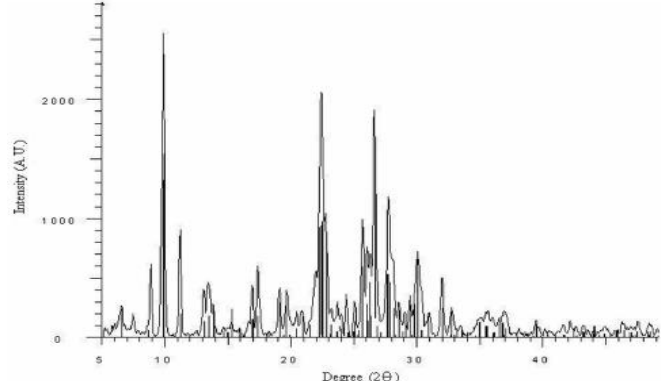
Fig. 1. XRD analysis of Miyaneh clinoptilolite Figure 1: XRD analysis of Miyaneh clinoptilolite